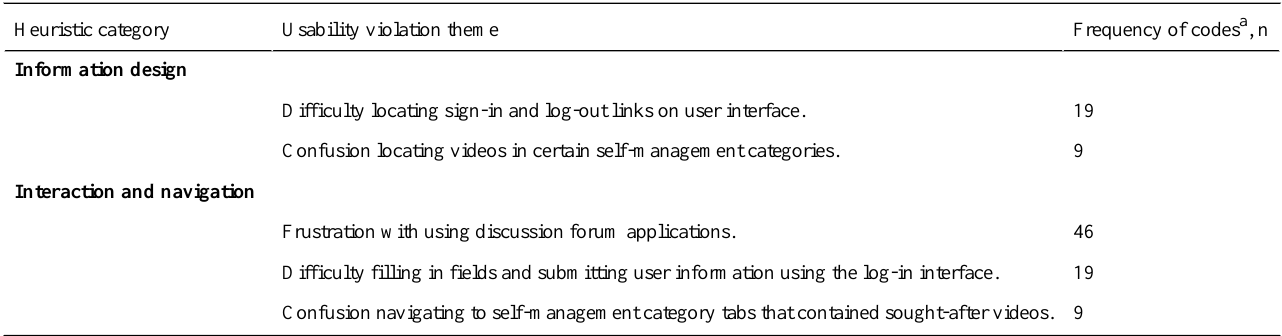
Table 6. Two main heuristic categories with usability